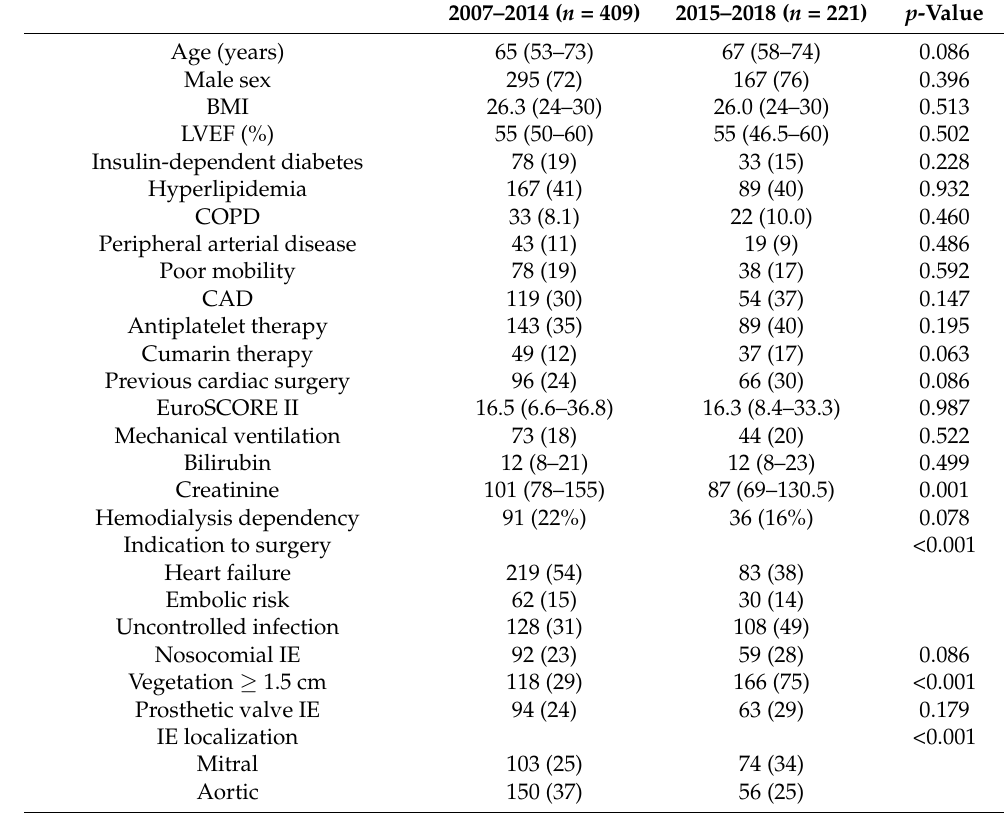
Table 1. Pre-operative patient characteristics for patients operated on in the first era (2007–2014) and in the second era